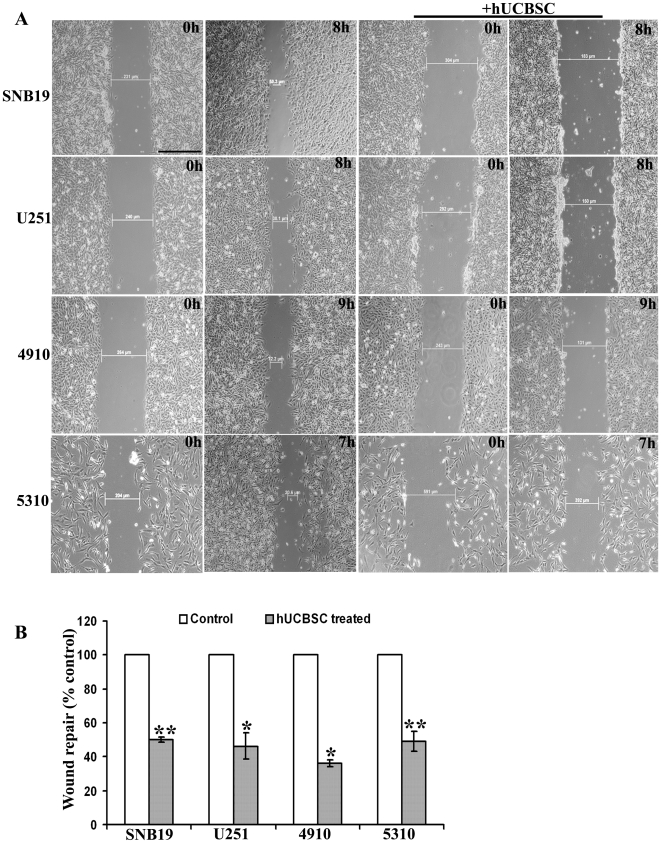
Monolayer wound-induced migration assay.A line was scratched with a 200-µm plastic pipette tip in SNB19, U251, 5310 and 4910 cultures and co-cultures with hUCBSC. They were allowed to grow at 37°C in 5% CO2 atmosphere. Every three hours, cells that had migrated to the wounded areas were photographed under a microscope for quantification of cell migration. Images are representative of three separate experiments. Scale bar  = 500 µm. (B) Quantitative analysis of wound-induced migration assay from (A). The results are presented as mean ± SEM of three experiments done in duplicate. *p <0.05. **p <0.001.